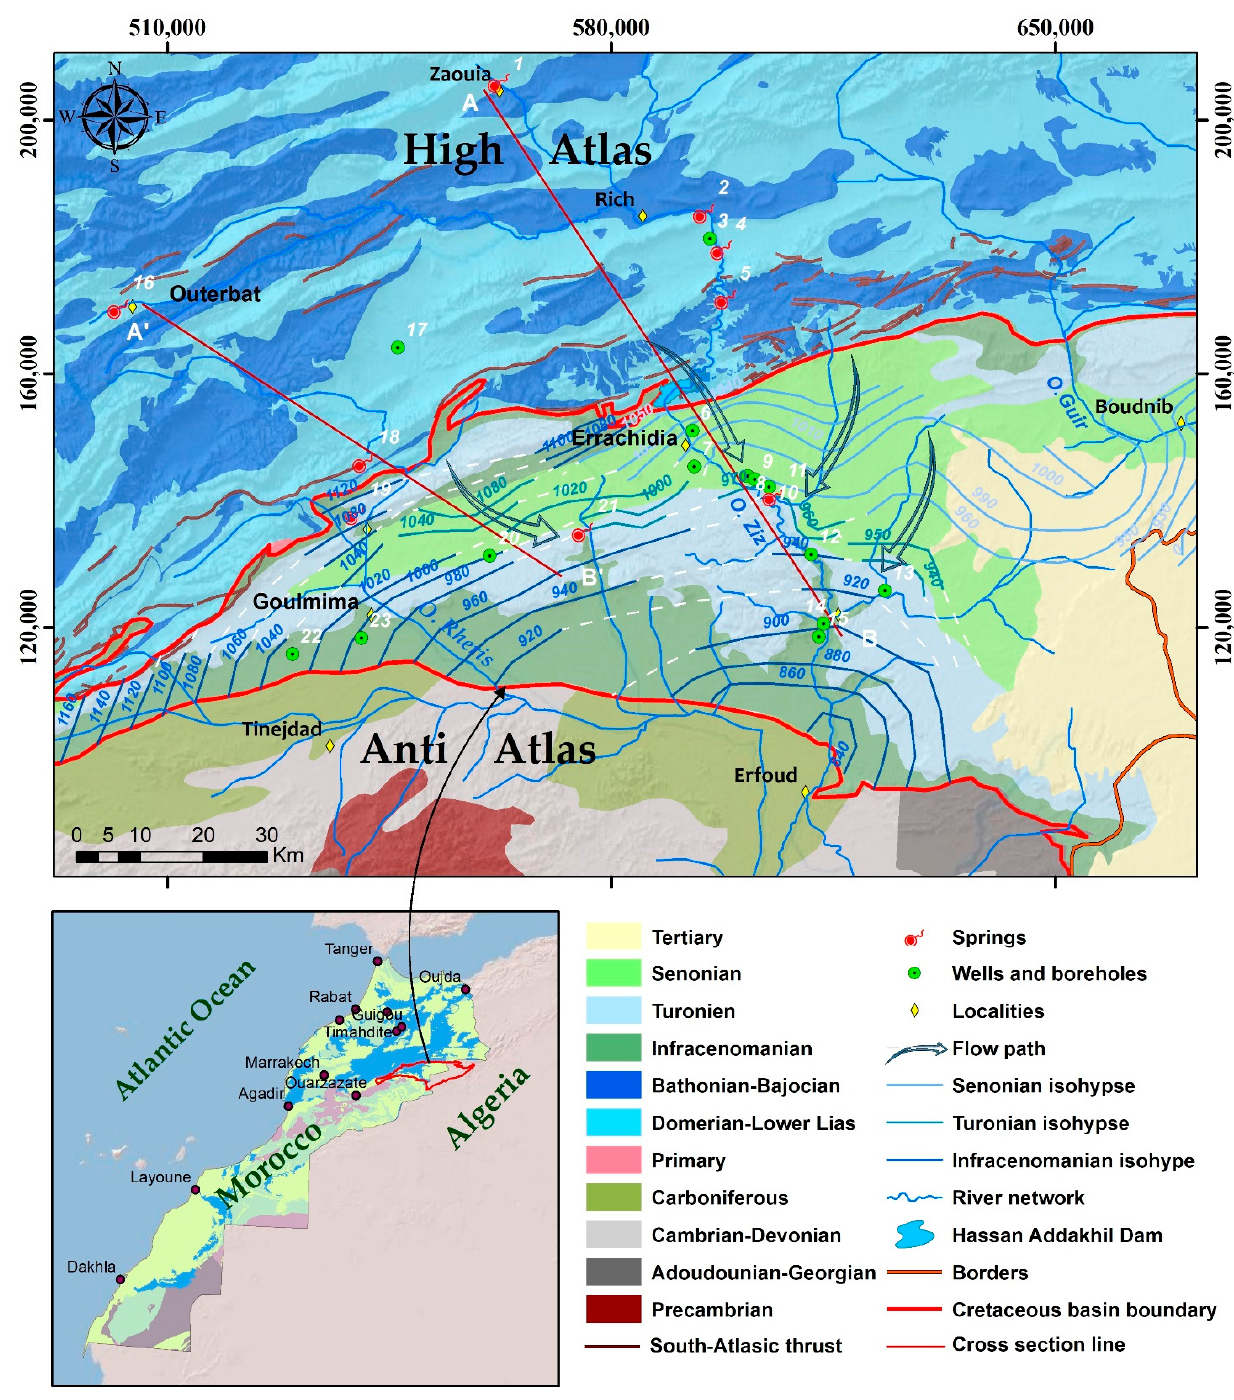
Figure 1. Geological map of the study area realized from the digitalization of the geological maps 1/200,000e of: “High Atlas of Midelt” [32] and “High Atlas North of Ksar Essouk and Boudenib” [33], hydrological network, samples location (white color), and hydrogeological sketch (October 2020).